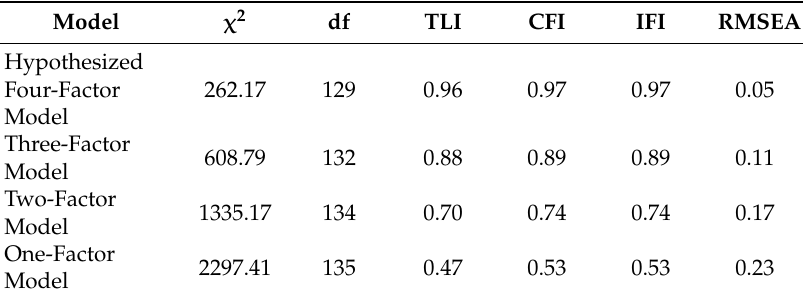
Table 1. Comparison of model fit indices.